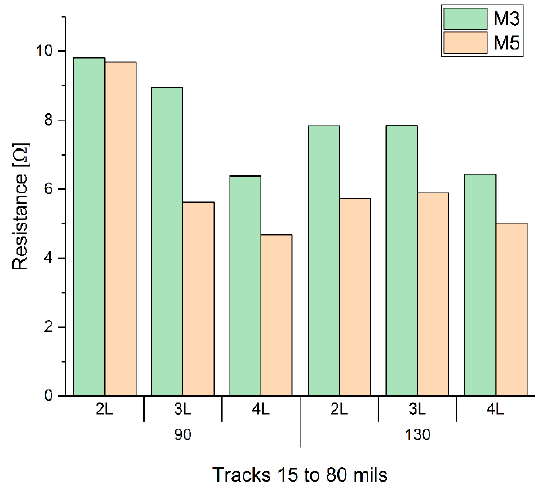
Figure 6. Average resistance of the set of tracks from 15 to 80 mils (0.381 to 2.032 mm), as a function of inks, M3 and M5, number of printings (2L, 3L, and 4L) and meshes of 90 and 130 threads/cm.